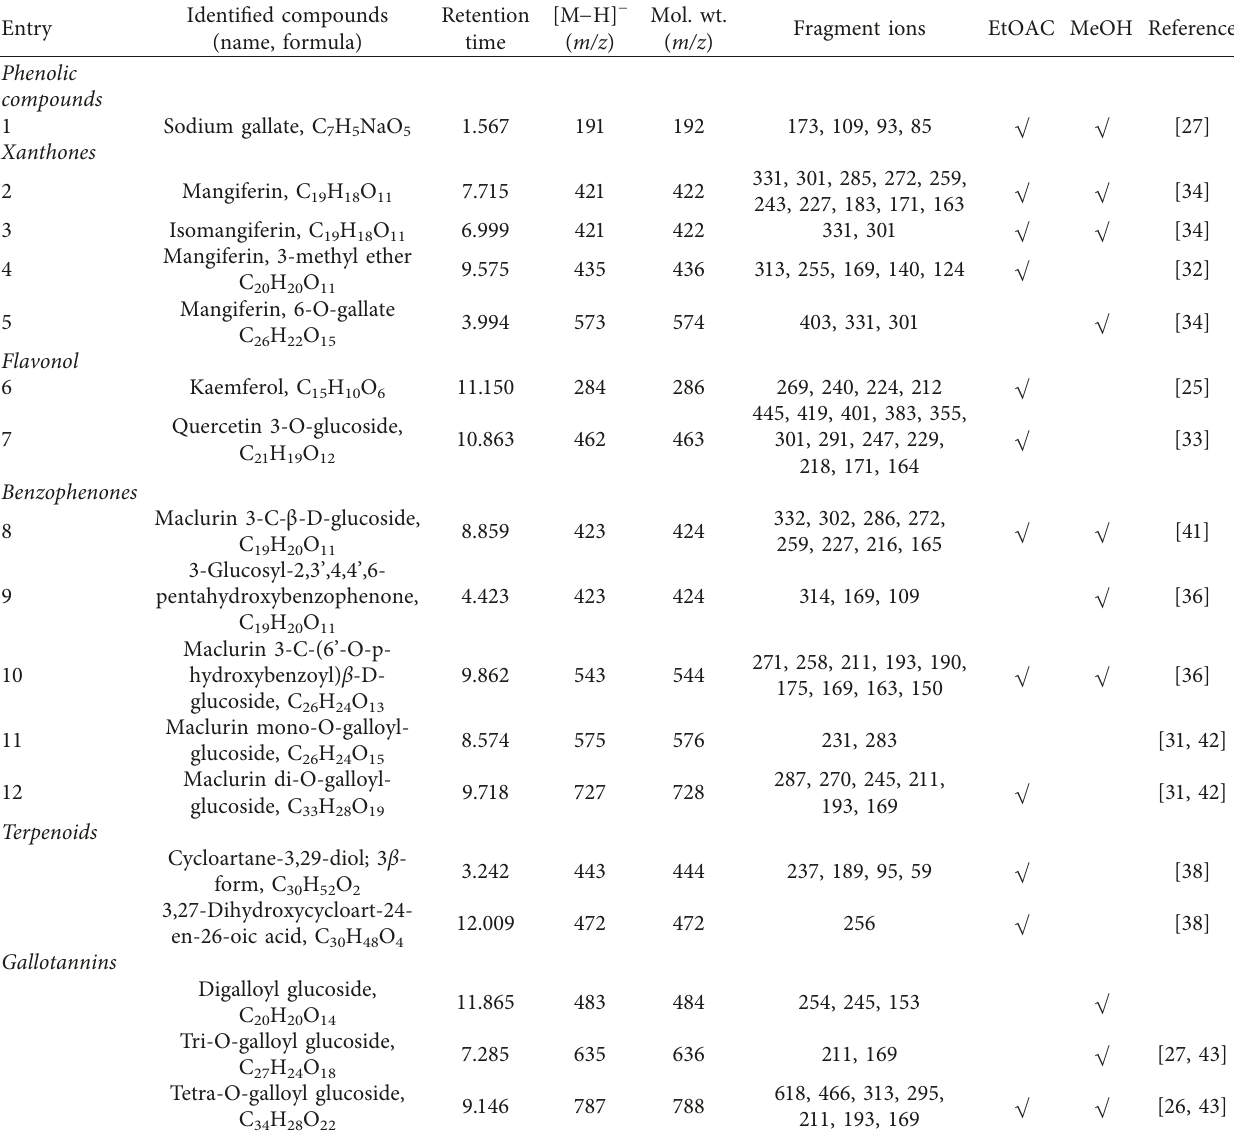
Table 4: Compounds determined by UPLC-MS/MS in the EtOAC and MeOH extracts of Mangifera indica in the negative-ion mode.